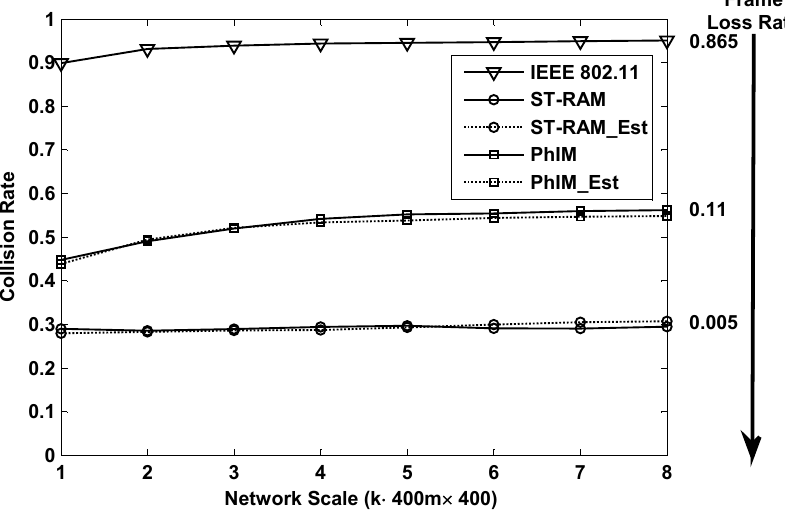
Figure 7. The collision rate and frame loss rate of different data collection methods for lattice deployed networks with different